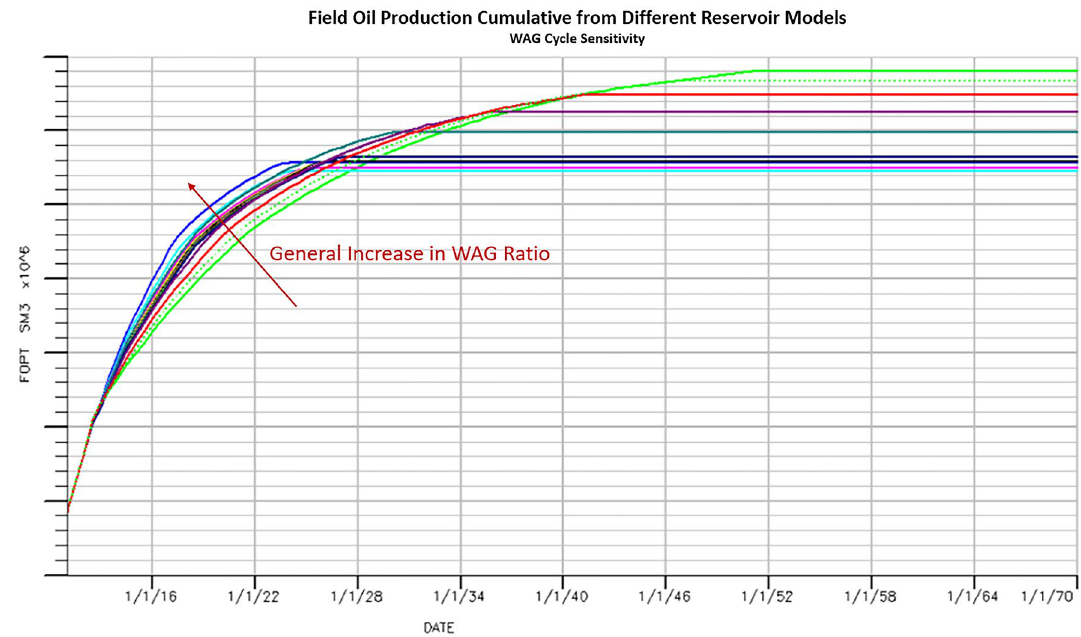
Fig. 7 Impact of WAG ratio on WAG recovery